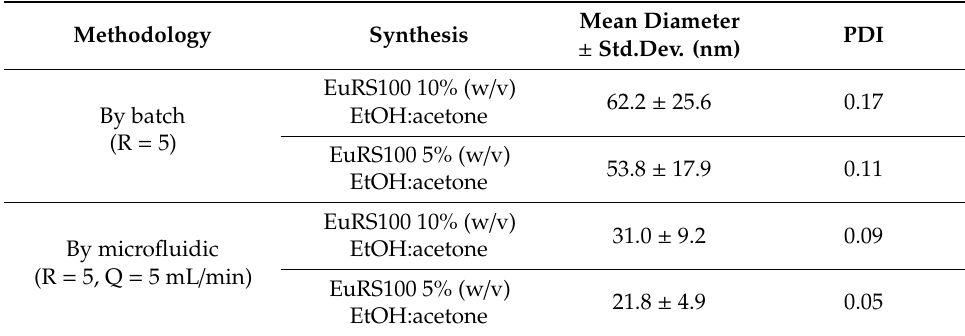
Table 5. Mean diameter and PDI comparison between batch and continuous flow production: e ff ect of polymer concentration in the ASP.